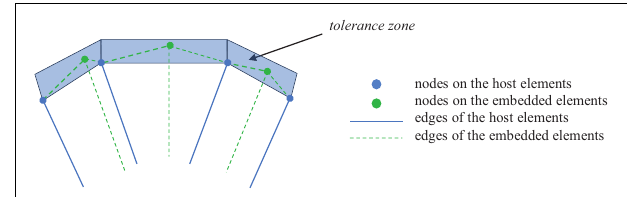
FIGURE 1 | Perfect bond model.